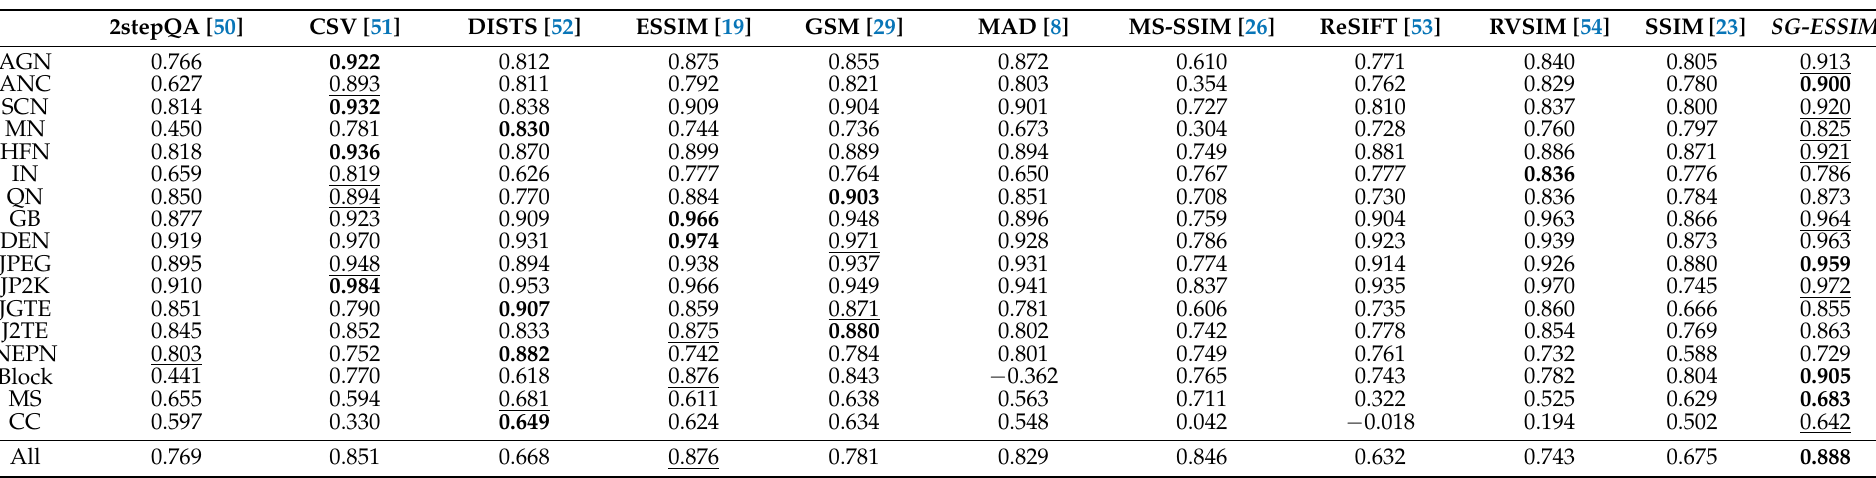
Table 7. Comparison of TID2008’s [21] distortion types. SROCC values are given. The highest values are typed in bold , while the second highest ones are underlined.